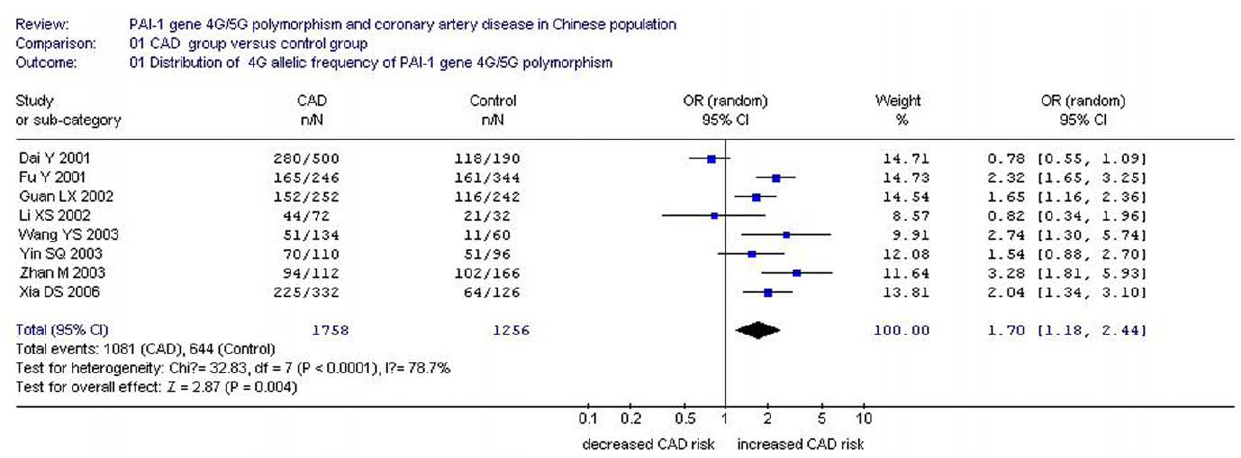
Figure 1. Forest plot of coronary artery disease associated with 4G/5G gene polymorphism (distribution of 4G allelic frequency of plasminogenactivatorinhibitor-1 4G/5G gene).